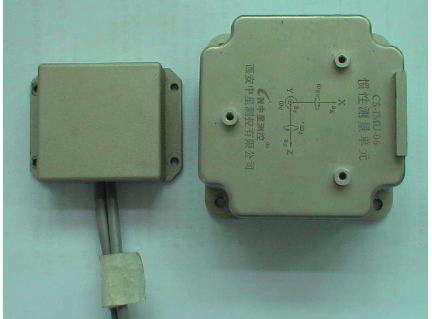
Figure 14: Inertial measurement